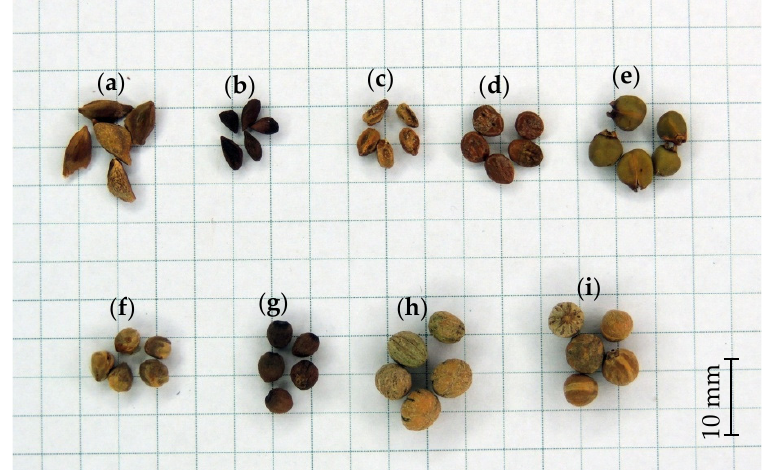
Figure 1. Seeds of ( a ) Pseudotsuga menziesii (Mirb.) Franco, ( b ) Picea abies (L.) H. Karst., ( c ) Juniperus communis L., ( d ) Cotoneaster horizontalis Decne., ( e ) Frangula alnus Mill., ( f ) Juniperus scopulorum Sarg., ( g ) Tilia cordata Mill., ( h ) Cornus sanguinea L., and ( i ) Cornus macrophylla Wall. Table 1. Analyzed seed samples.